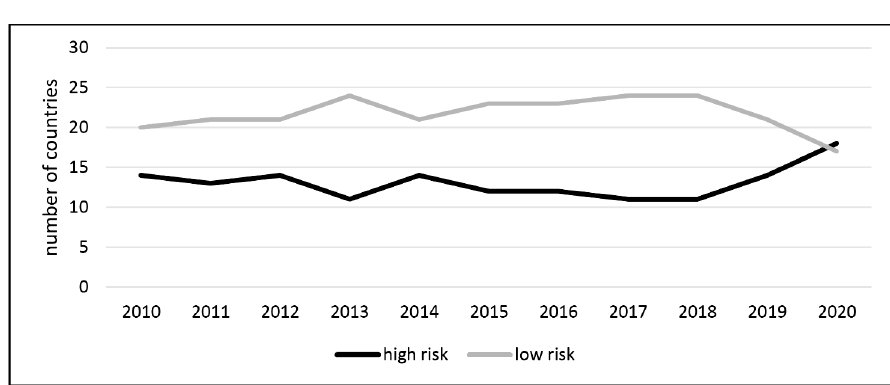
Figure 3 Change in financial risk in OECD countries